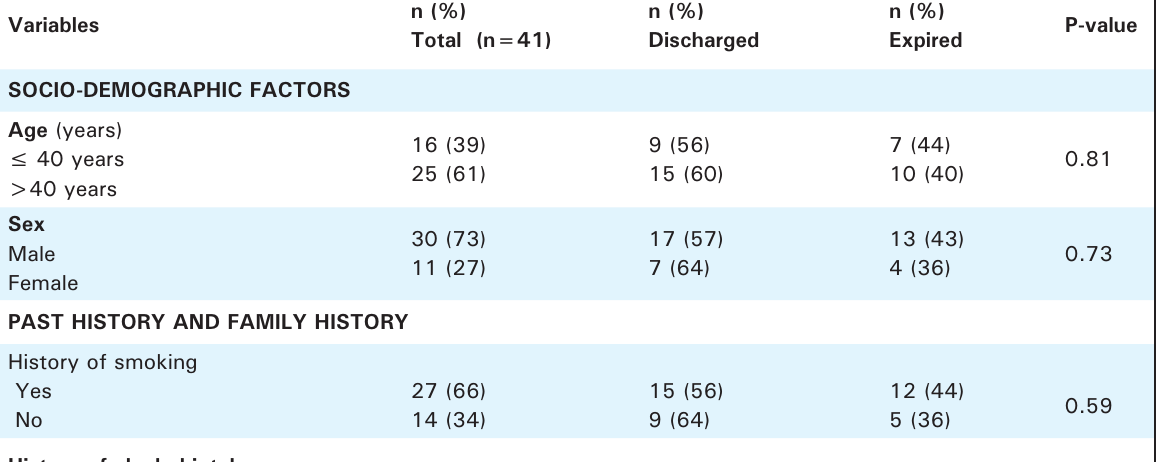
Table 2. Associations of risk factors with mortality among lung abscess patients (n=41).